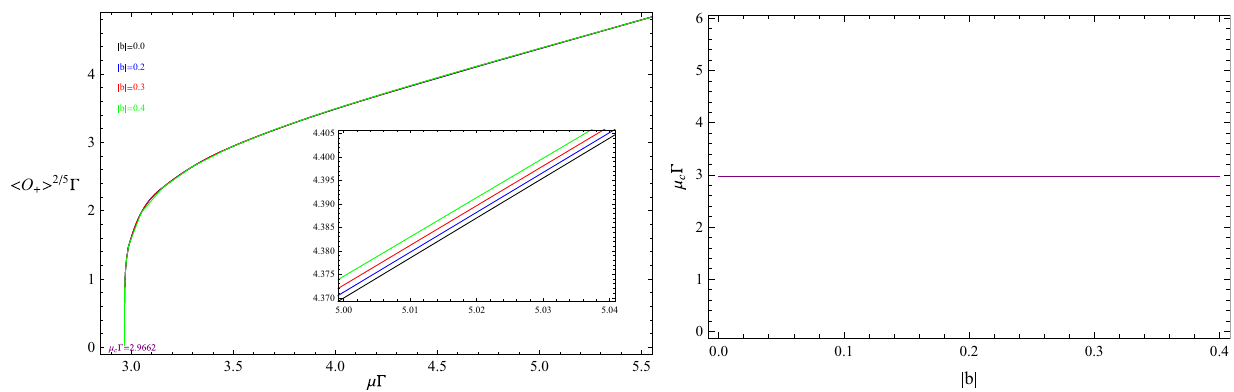
Fig. 1 The condensate of operator (cid:8) ˆ O + (cid:9) (left plot) as a function of chemical potential μ for different parameter b and the critical chemical potential μ c (right plot) versus the ENE factor b . The different color correspond to the different value of parameter b